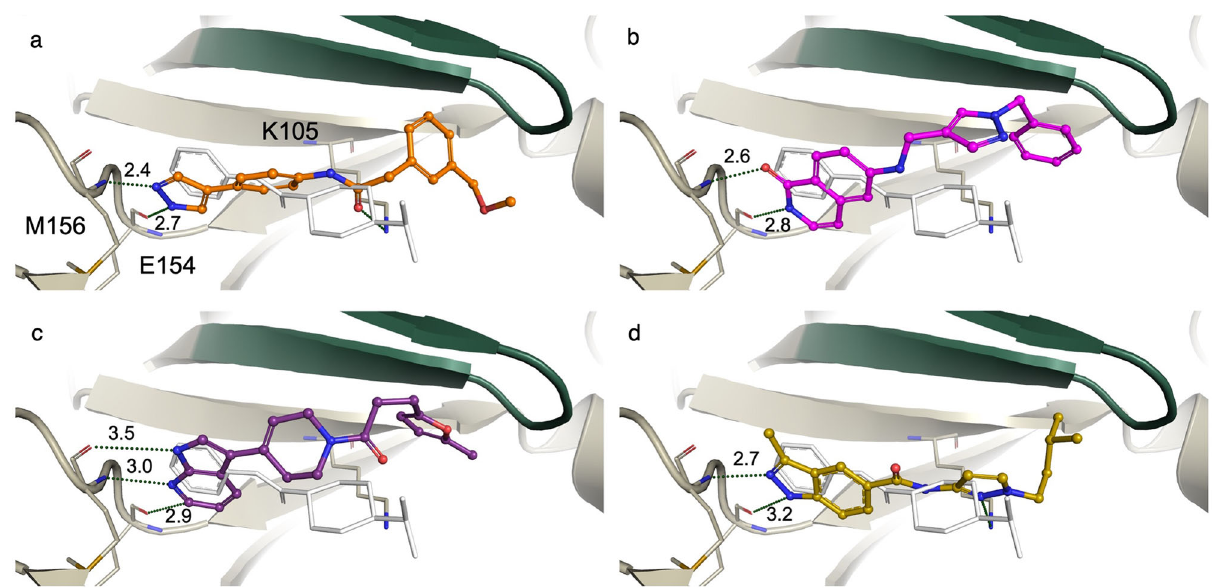
Fig. 3 | Docked poses for the most active molecules from each of the four chemotypesidenti fi ed. The hinge residues are atthe left and the P loop(green)is atthetopofeachpanel,whiletheoriginal2ETRligandisshowninthinwhitesticks for reference. a Compound 1 (pyrazole) in orange. b Compound 16 (pyridone) in